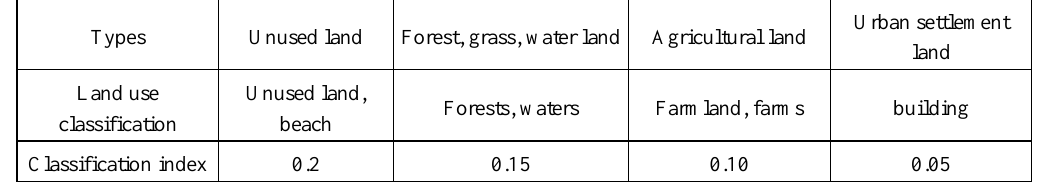
Table 3 Chaohu Lake Basin land use types of